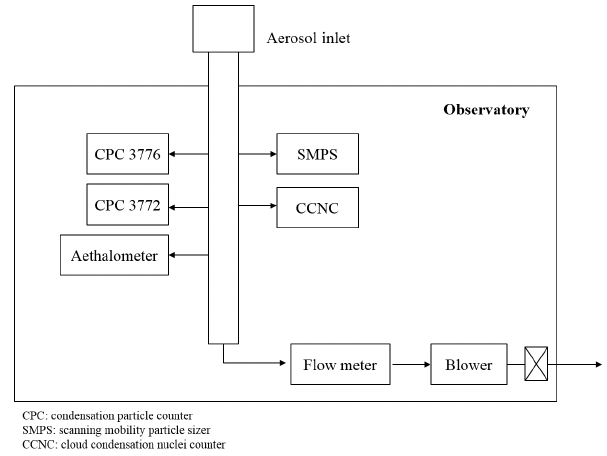
Figure 1. A schematic diagram for the observation methods used in this